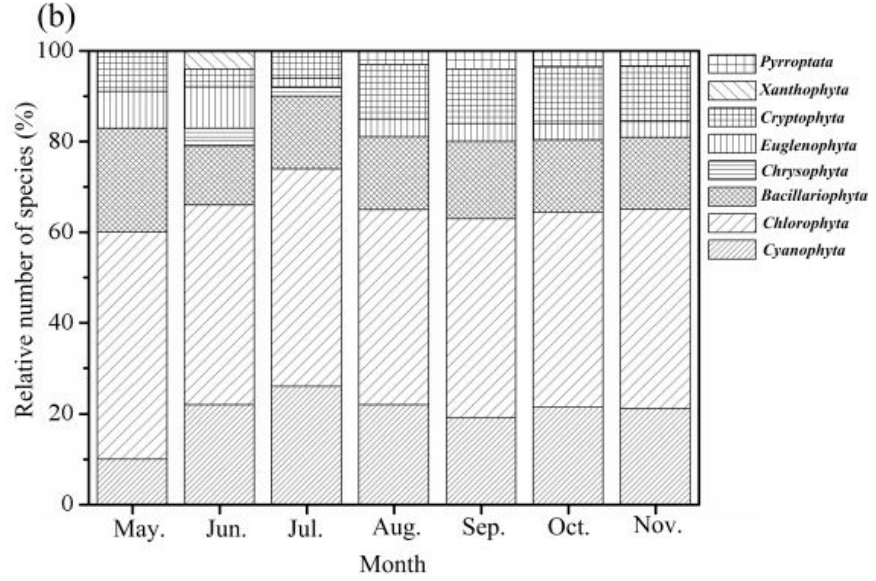
Figure 4. ( a ) Relative abundancy of species within different segment of the stream; ( b ) During different months.